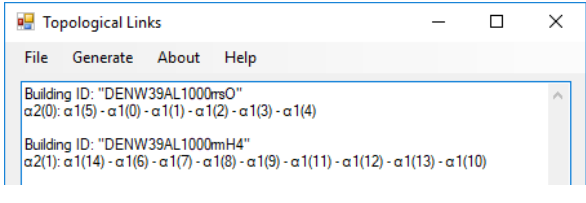
Figure 14. a-2 links for Dataset A